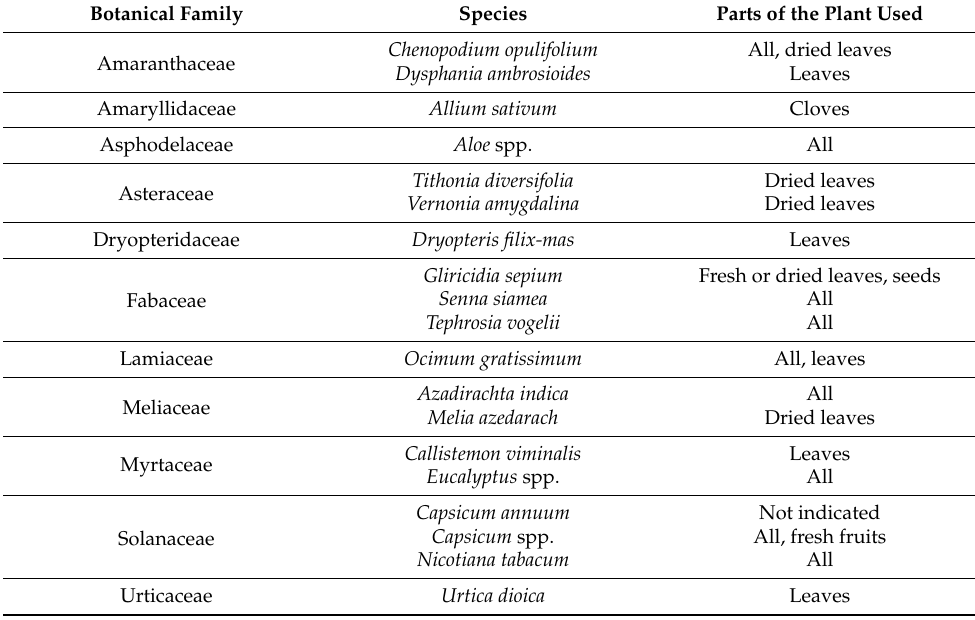
Table 2. Examples in KB of plant genera and species and parts of the plant used for the protection of bean ( Phaseolus vulgaris ).